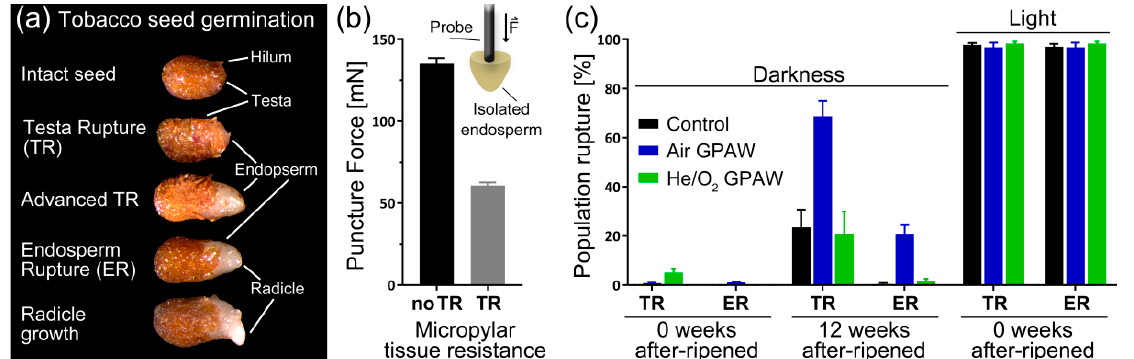
Figure 1. Nicotiana tabacum seed germination. ( a ) Different stages of the germination process showing testa rupture (TR), endosperm rupture (ER) and radicle elongation. ( b ) Force needed to puncture the micropylar part of the endosperm before and after testa rupture. ( c ) Comparison of 0 and 12 week after-ripened (33% RH and 20 °C) seeds’ testa rupture (TR) and endosperm rupture (ER) (7 days after imbibition in both dark and light germinated in water or gas-plasma-activated water (GPAW)).